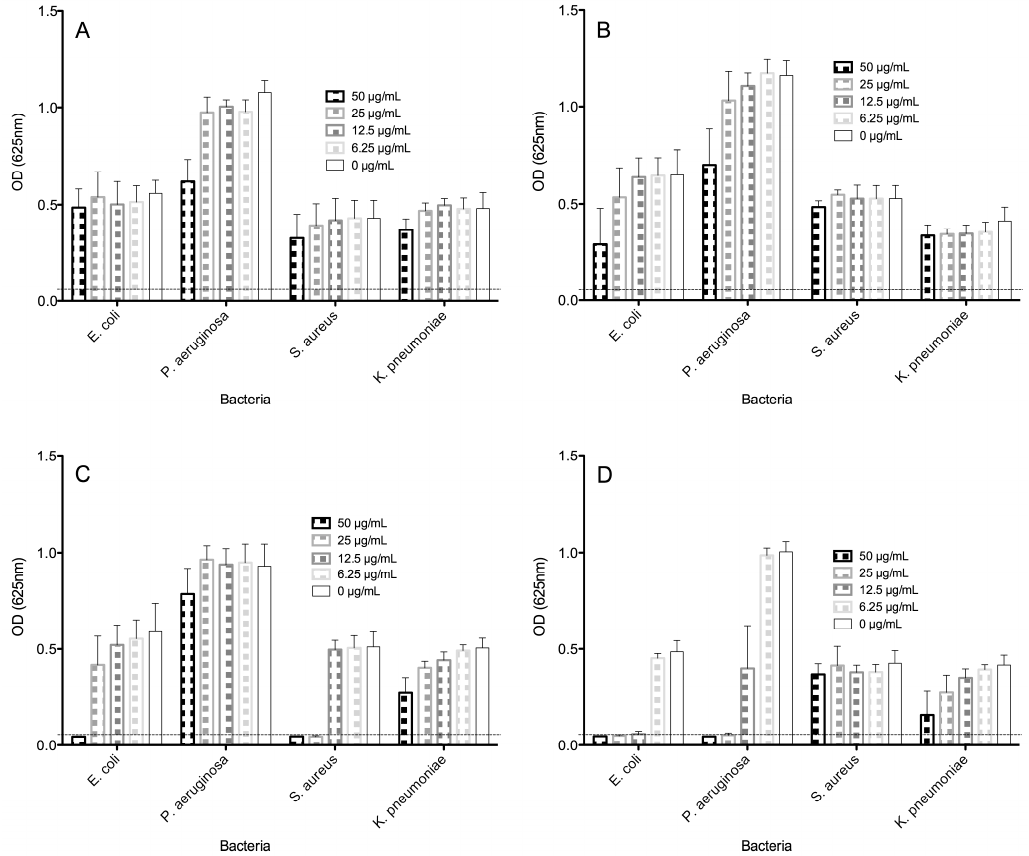
Figure 2. Antimicrobial activities of peptides against bacteria. Different concentrations of Antimicrobial peptides (AMPs) were challenged against the growth of E. coli ATCC 25922, S. aureus ATCC 25923, Pseudomonas aeruginosa ATCC 27853 and Klebsiella pneumoniae ST258 in Muller-Hinton broth ( n = 8). ( A ) Pin2[14]; ( B ) P18K; ( C ) Pin2[G] and ( D ) FA1. Bacteria-free well absorbances are indicated by a dotted line.